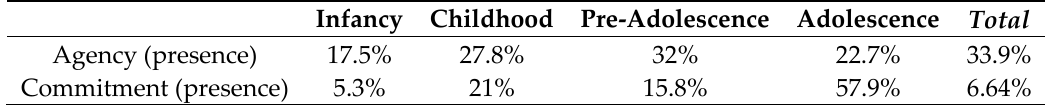
Table 6. Markers “Agency” and “Commitment”: percentages on the total of the drawings assigned to these two indicators (97 and 19, respectively).